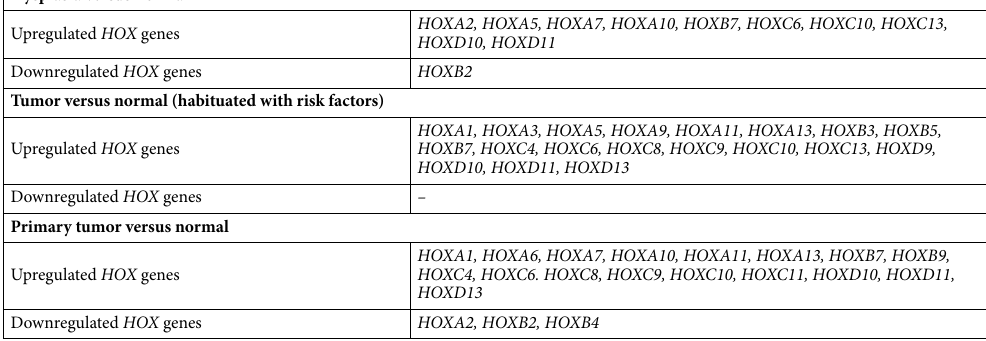
that the differential expression of HOX genes was associated with the progression of oral cancer although the associated risk factors influenced the clinical outcome. HOX gene expression in oral cancer cell lines. The profile of HOX gene expression in oral cancer cell lines specific to their site of origin is provided as Supplementary File S2. The expression of HOXA1, HOXA7, HOXA10, HOXB7, HOXB9, HOXC4, HOXC6, HOXC9, HOXC10, HOXD10 and HOXD11 was consistent in both the primary tumor samples from the tongue as well as cell lines, PECAPJ15 (RRID: CVCL_2678), PECAPJ49 (RRID: CVCL_2681), SCC-25 (RRID: CVCL_1682). Likewise, the buccal mucosa-derived H157 (RRID: CVCL_2468) cancer cell lines showed overexpression of HOXA10, HOXC6, HOXC9, HOXC10 and HOXD11 which was consistent with the cancer of the buccal mucosa. Further, HOXA1, HOXA10, HOXB7, HOXB9, HOXC6, HOXC9, HOXC10, HOXD10 and HOXD11 showed similar expression patterns in both the primary tumor-derived mouth neoplasms and the cell lines, with some variation noted for HOXB9 in H376 (RRID: CVCL_2463), and HOXC6 with respect to UPCI-SCC-131 (CVCL_2229) cell lines. The downregulated HOXB2 and HOXB4 were consistent across all the 19 cell lines screened. However, the expression patterns were modestly diverse across each cell line screen. This was perhaps due to the cancer cell heterogeneity with respect to the primary site of the tumor and its biological behavior. However, the average expression profile of the HOX genes in the cell lines when pooled together was similar to those of the patients’ tissue panel validated experimentally (Figs. 2a–b and 4a–b; Supplementary File S1 & S2). HOX genes as developmental cues in oral carcinogenesis. The differentially expressed HOX genes had hits against the developmentally related events such as epithelial morphogenesis, monocyte differentia- tion including cell fate specification, and commitment (Fig. 5a). Any alteration in the functional state had con- sequences leading to phenotypic abnormalities. HOXA10 participated in the transcriptional misregulation in cancer (Table 2) influencing upstream and downstream target interactions as reported previously 41 . HOXB9 was involved in the regulation of the BTG (B-cell translocation gene 1–4) family of proteins which functions in the cell cycle mediated events during cancer progression 42 and was also noted to function as an angiogenic switch along with HOXB7 (Fig. 5b). Two other posterior HOX genes, HOXD10 , and HOXD11 were shown to be associ- ated with the mouth neoplasm based on the semantic analysis performed using DO (Fig. 5b). HOXA11 , HOXC4 and HOXC6 (Fig. 5b) expression was upregulated in patients with positive habit history (Fig. 3c). HOX showed interactions with notable key regulators. HOX genes subnetwork analysis showed crucial interactions with cell cycle regulators such as Geminin ( GMNN ), CDKN2A (cyclin-dependent kinase inhibitor 2A), cell division cycle ( CDC ) associated genes such as CDC6 , 14A , 20 , 27 , transcriptional regulators